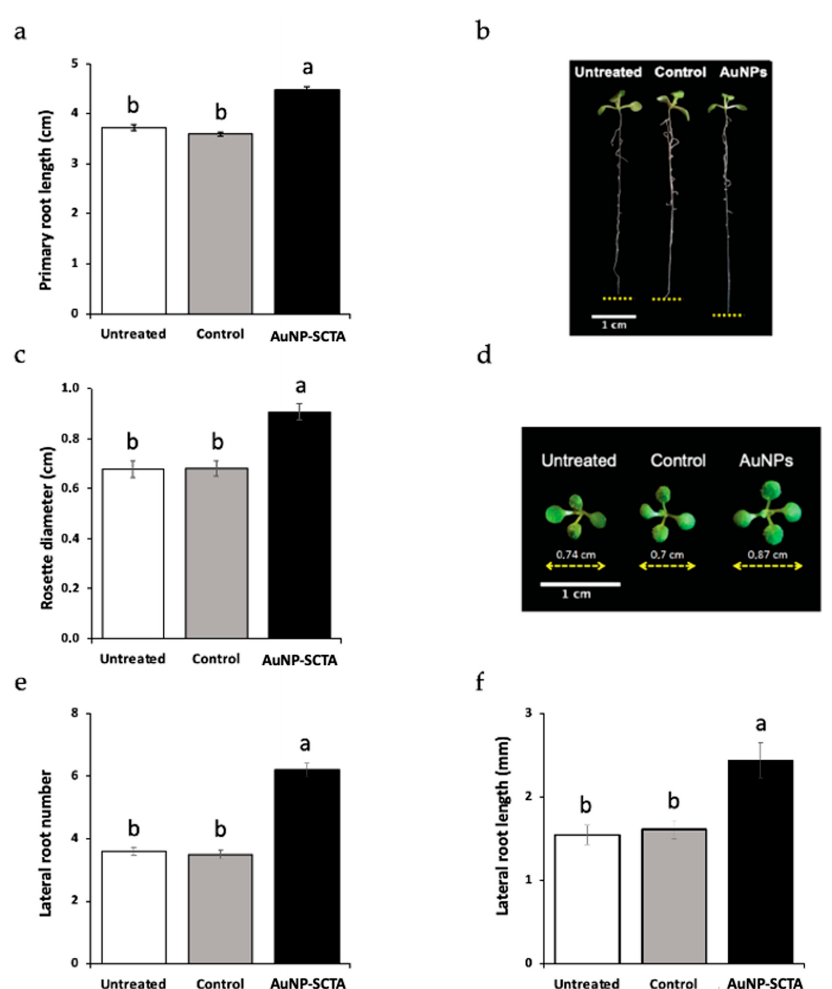
Figure 3. AuNP-SCTA enhances growth of Arabidopsis seedlings. Wild-type Arabidopsis seedlings were grown for 7 d on agar-solidified ½ MS medium containing 10 mg/L of AuNP-SCTA or SCTA (SC 2.2 mM; TA 200 μ M) (control) or on un-supplemented medium (untreated). Growth parameters were scored: ( a ) primary root length and ( b ) representative picture of ( a ). ( c ) Rosette diameter and ( d ) representative photograph of ( c ). ( e ) Lateral root number. ( f ) Lateral root length. Results shown are means ± SE with n = 20. Different labels a and b indicate statistically different groups according to multiple comparisons following one-way ANOVA analysis at a probability level of p < 0.01. All experiments were repeated twice with similar results.